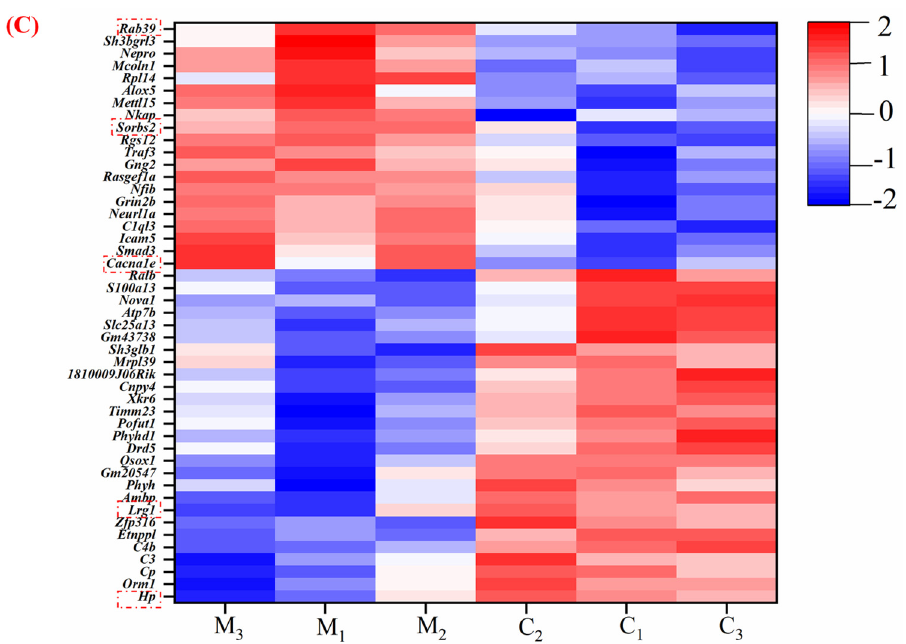
Figure 4. ( A ) Interaction map of differential expression proteins; ( B ) volcano plot of the differentially expressed protein in the M group compared to the C group; and ( C ) the differentially expressed protein expression heatmap. The blue represents the lower expression level. The white represents the median value, and the red refers to the higher expression level. (C1, C2, C3 and M1, M2, M3 represent parallel samples of the control and experimental groups, respectively). Genes in red dashed boxes in C are strongly correlated with memory and cognitive ability.